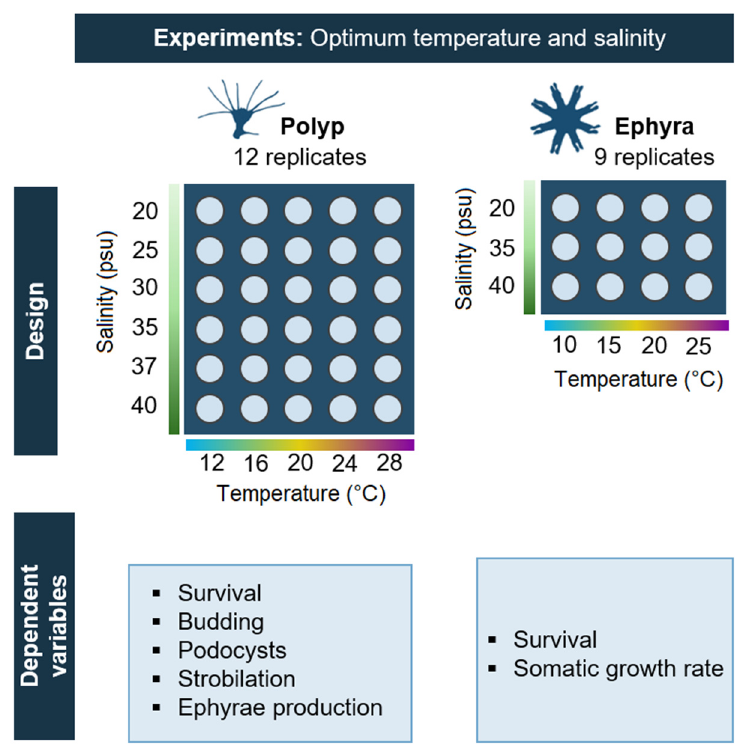
Figure 1. Study design and dependent variables for the optimum temperature and salinity experi- ments on Aurelia solida polyps and ephyrae.